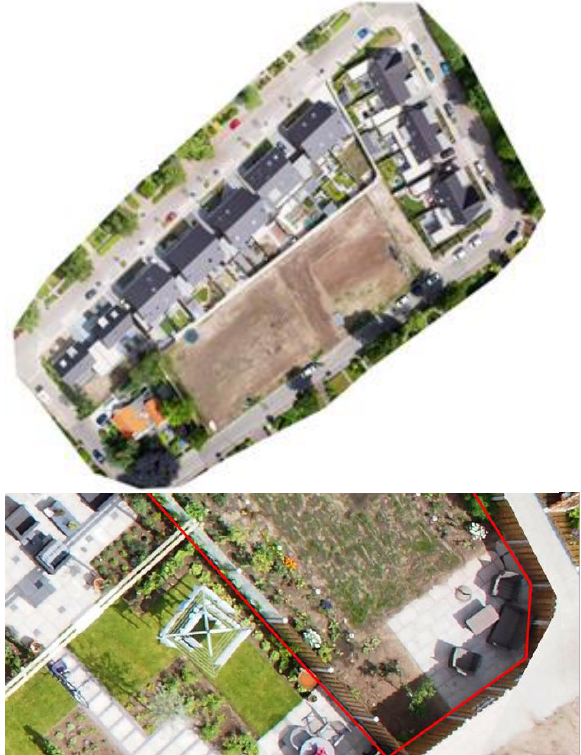
Figure 13: Orthophoto Nunspeet and zoomed-in orthophoto with cadastral borders (in